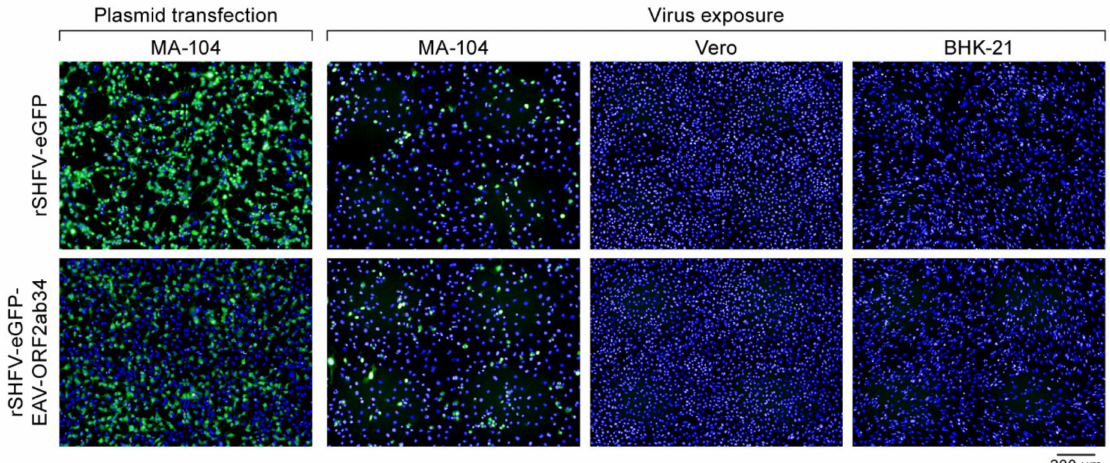
Figure 8. Replacement of the recombinant wild-type simian hemorrhagic fever virus (SHFV) expressing enhanced green fluorescent protein-expressing (rSHFV-eGFP) open reading frames (ORFs) encoding the minor structural proteins E, GP2, GP3, and GP4 with ORFs encoding presumed EAV orthologs does not expand SHFV cell tropism. MA-104 cells were transfected with a plasmid encoding rSHFV-eGFP control (top) or chimeric rSHFV-eGFP (bottom). At 48 h post-transfection, eGFP expression was measured by epifluorescence microscopy. Supernatants (containing rSHFV-eGFP or rSHFV-eGFP- EAV-ORF2ab34) were harvested and used to expose fresh MA-104, Vero, and BHK-21 cells at a multiplicity of infection of 1. Success of infection was measured by epifluorescent